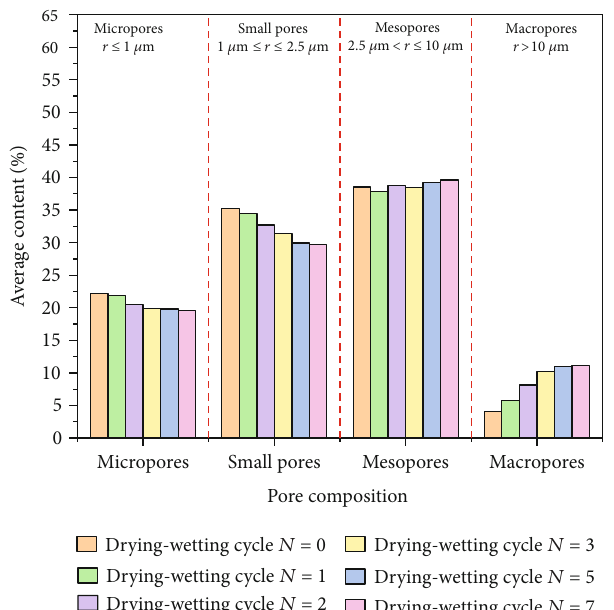
Figure 6: Distribution of various pore contents of samples under di ff erent drying – wetting cycles.